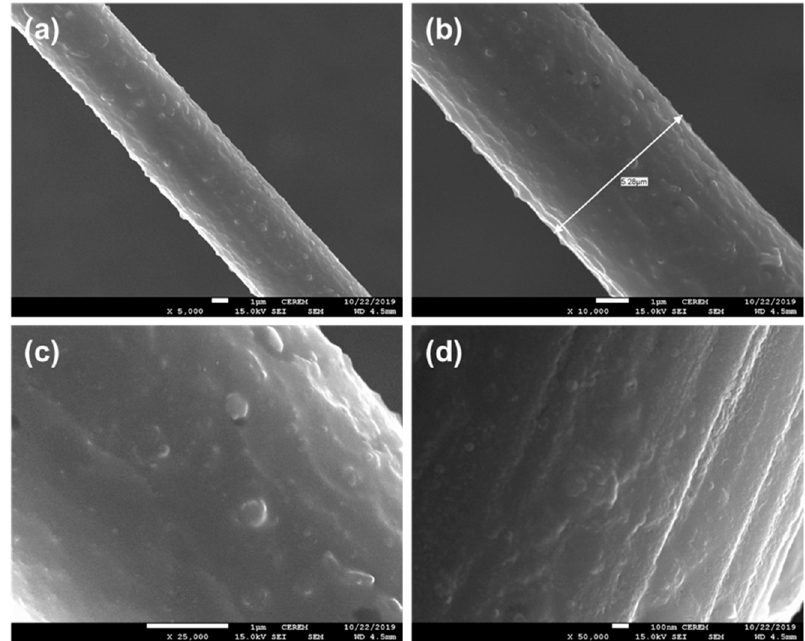
Figure 6. SEM images with different magnifications of the carbon fibers surface-treated with chromic acid. ( a – d ) Low to high resolutions.